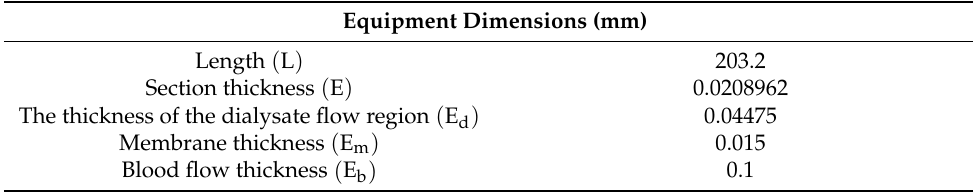
Figure 1. Scheme of the dialyzer operation. The hollow fiber membrane consists of three parts: the shell (dialysate flow region), the porous membrane, and the lumen (blood flow region). Inside the equipment, blood (water and urea contaminant) flows into the lumen domain and the dialysate into the shell domain, with the flow in opposite directions (countercurrent), as illustrated in Figure 2. The dimensions of the equipment are listed in Table 1. Table 1. Dimensions of the hollow fiber membrane